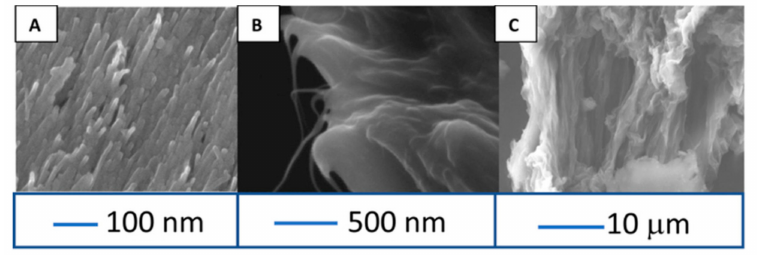
Figure 6. Cross-sectional SEM images of carbon nanotube (CNT) yarn ( A ), PEI-CNT fiber ( B ), and acid spin CNT fiber ( C ). Reprinted with permission